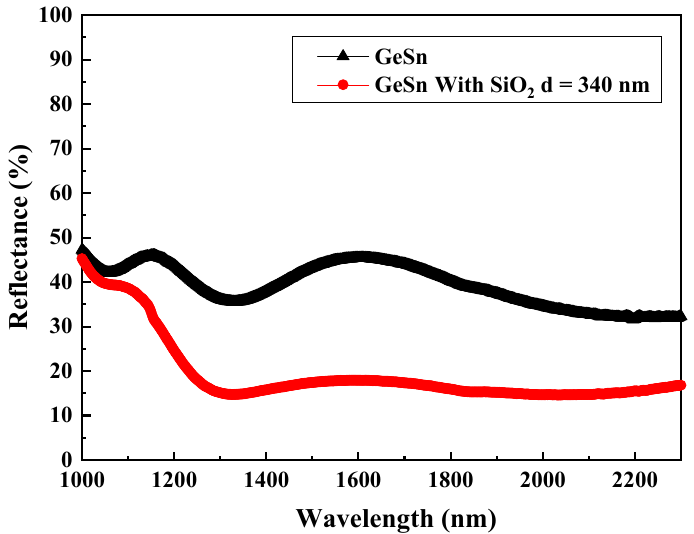
Figure 13. The reflectance plots of the GeSn samples with and without the coverage of the SiO 2 AR layers of 340 nm in thickness as a function of wavelength in the range of 1000~2300 nm.